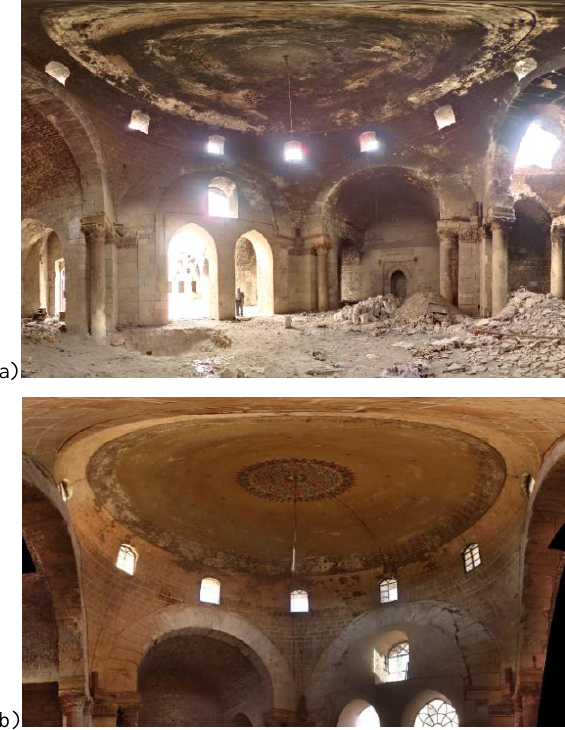
Figure 10: The el Haways madrasa interior, current situation (a) and how it was in 2010